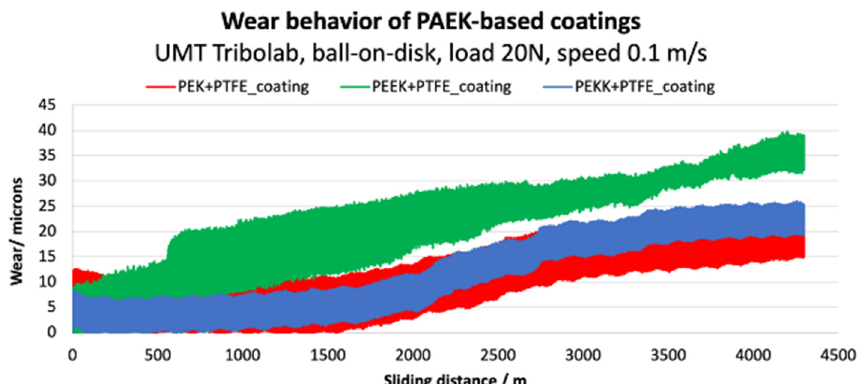
Figure 19. Friction coefficient average of each coating tested in a long-term testing conditions .